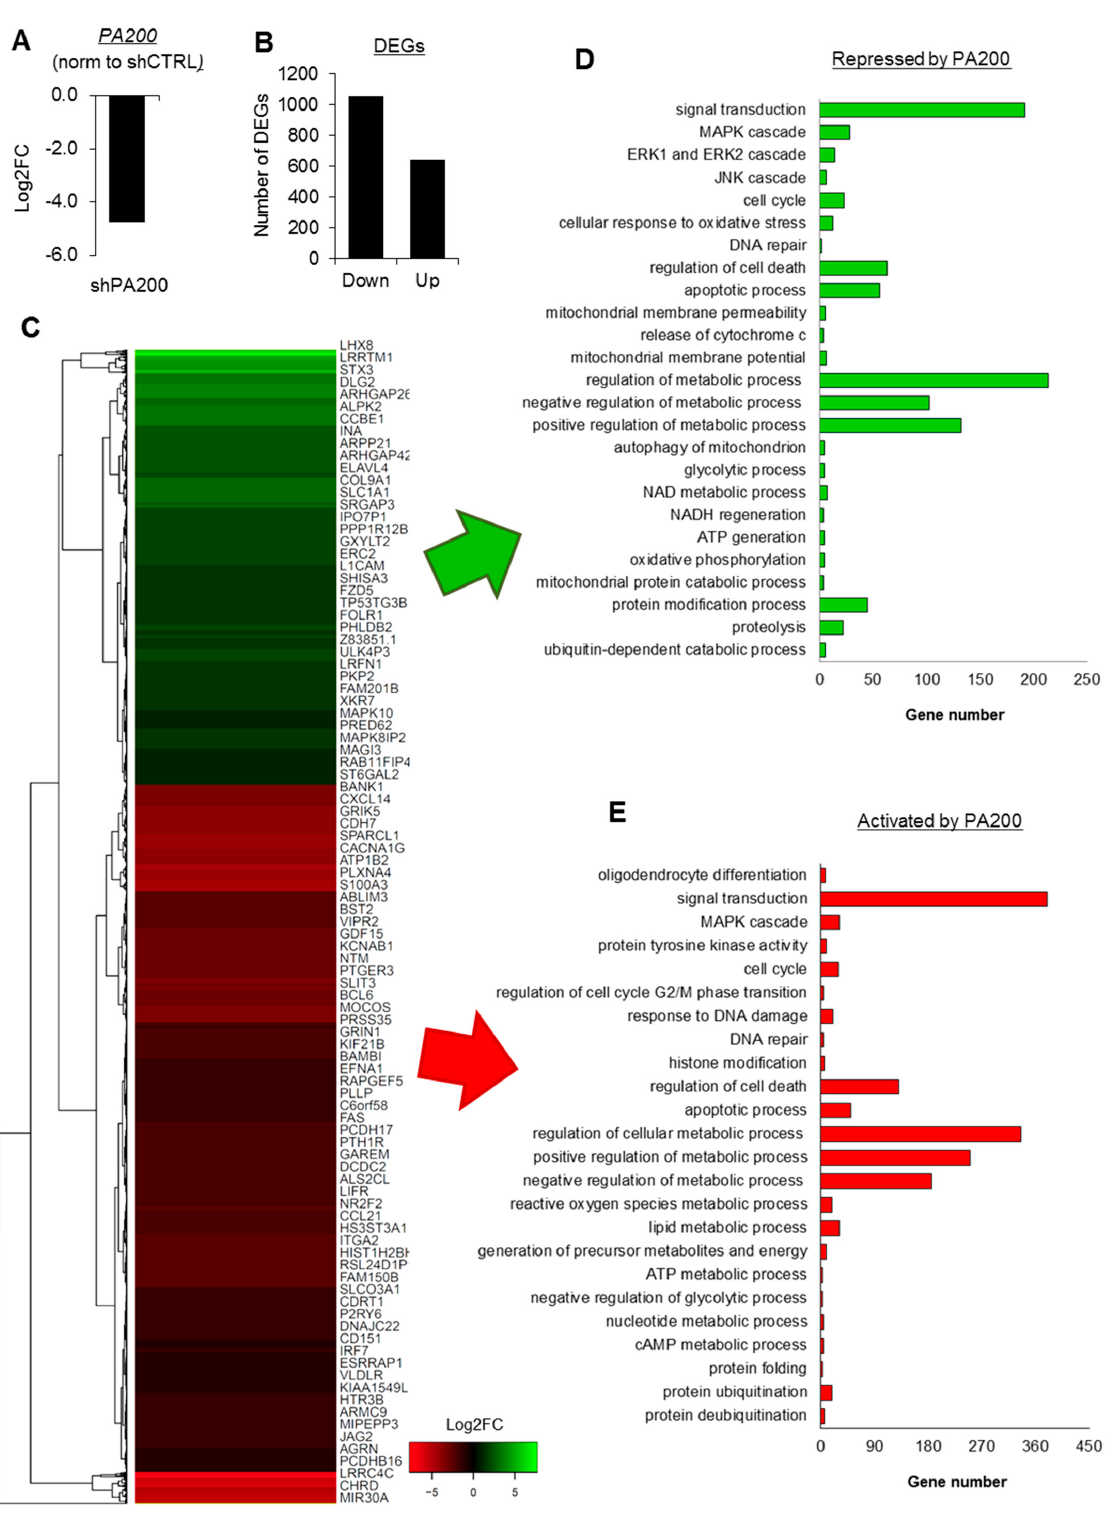
Figure 1. Deficiency of PA200 affects transcription of functionally relevant genes. ( A ) Analysis of RNA-Seq data confirmed depletion of PSME4 (gene name for PA200) mRNA in shPA200 knockdowns in SH-SY5Y cells. ( B ) Quantification of differential gene expression (DEGs) between shCTRL and shPA200 disclosed the subset of genes up- and down-regulated in PA200-silenced cells. ( C ) The heat map shows Log2FC of DEGs, which were clustered according to Euclidean distance measurements. The list on the right quotes every second gene. ( D , E ) The GO enrichment analysis for the genes activated and repressed after PA200